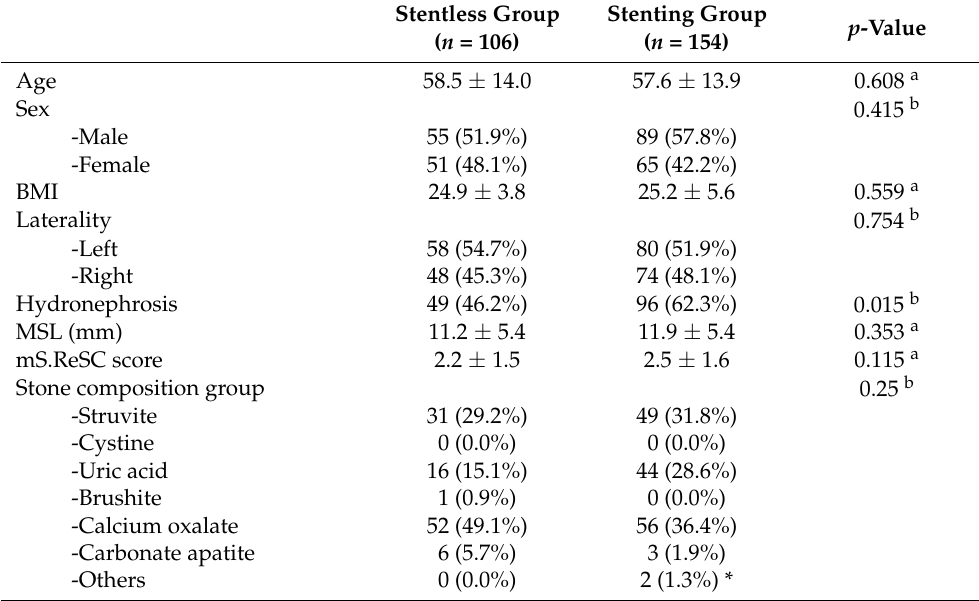
Table 1. Summary of patients and stone characteristics by preoperative stenting status.